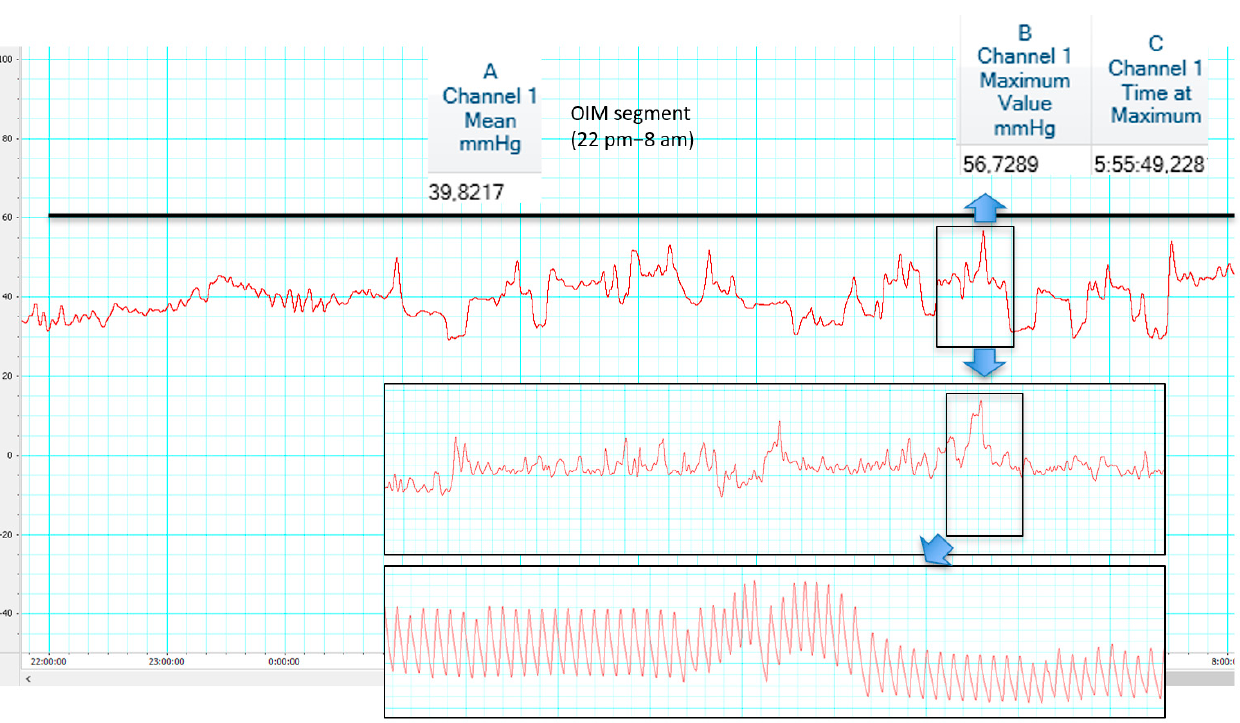
Figure 3. An 8-year-old patient with syndromic craniosynostosis and hydrocephalus, shunted at birth (also see Figure 5). Symptoms only partially improved after shunt optimization. ICP monitoring revealed irregular traces and raised ICP during OIM segment (2200 to 0800) with mean ICP of 39 mmHg and ICP peak over 56 mmHg at 05:55. High amplitude B waves (up to 20 mmHg) were found in slow wave segments where ICP pulse amplitude reached 20 mmHg and waveform had a triangular shape. Re-do posterior cranial vault gradual distraction was performed. Codman Microsensor ® ICP Transducer, Codman ® ICP EXPRESS Monitor ® (Integra LifeSciences Corporation, Princeton, NJ, USA)/ML856 PowerLab 26T,